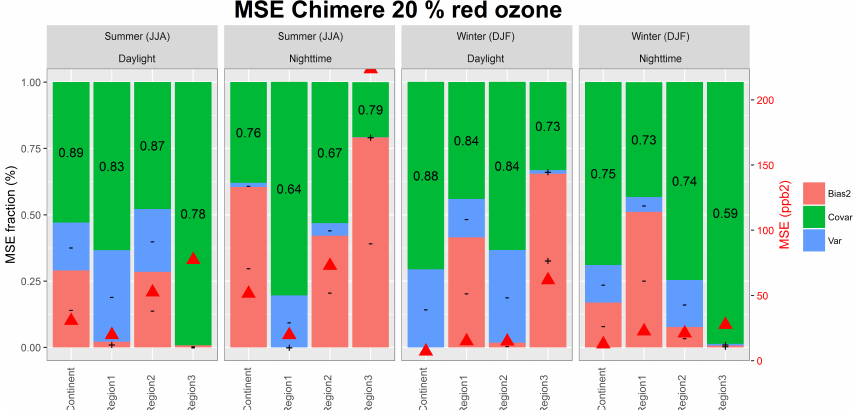
Figure 12. As in Fig. 11 for the hourly time series of “20% reduction” scenario